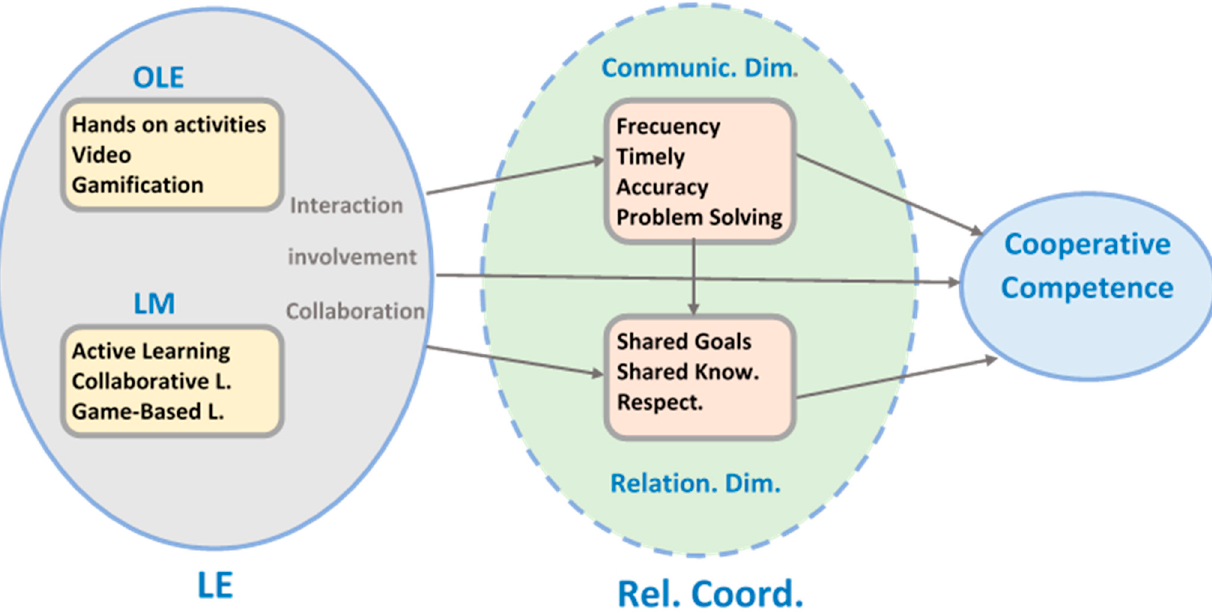
Figure 2. Conceptual research framework.